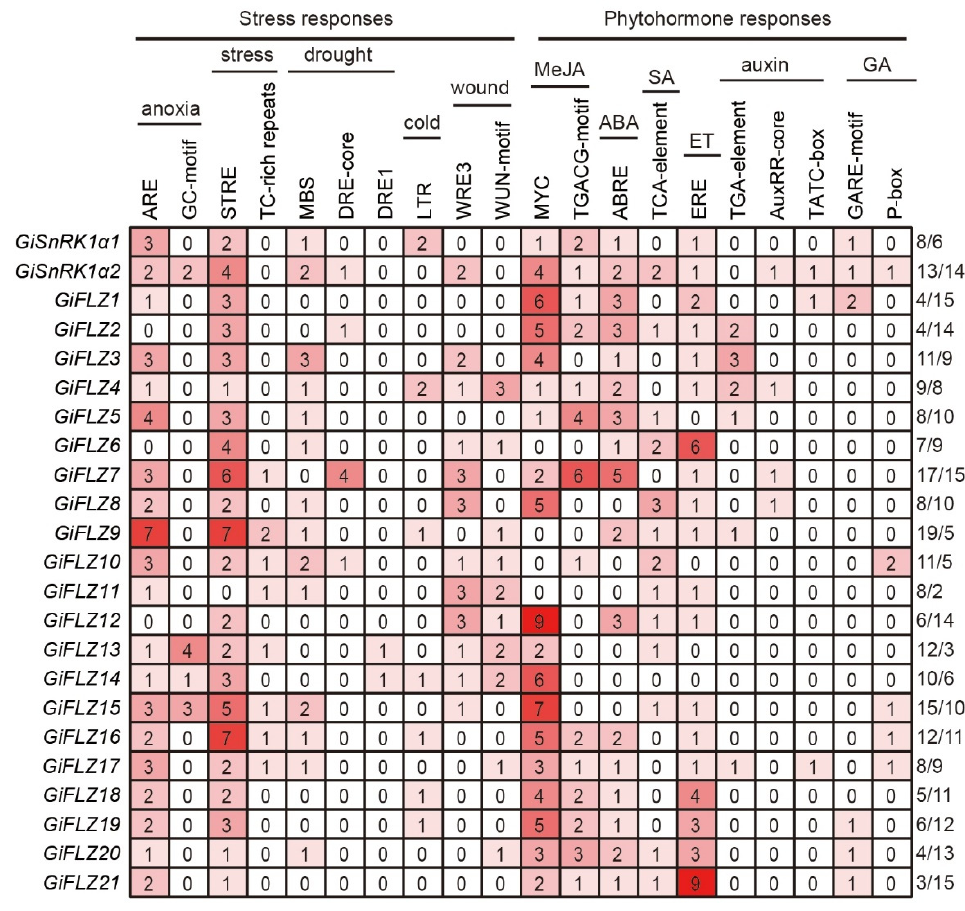
Figure 4. Cis-regulatory element analysis of GiSnRK1 α and GiFLZ gene promoters. The gradient colors in the red grid indicate the number of cis-acting elements in putative promoter regions of the GiSnRK1 α and GiFLZ genes. A white background behind the numbers means there were no cis-elements found in this category. The deeper the red color, the higher number of cis-elements. Numbers at the end of each line indicate the numbers of cis-element found for stress responses (left, before slash) and phytohormone responses (right, after slash), respectively.